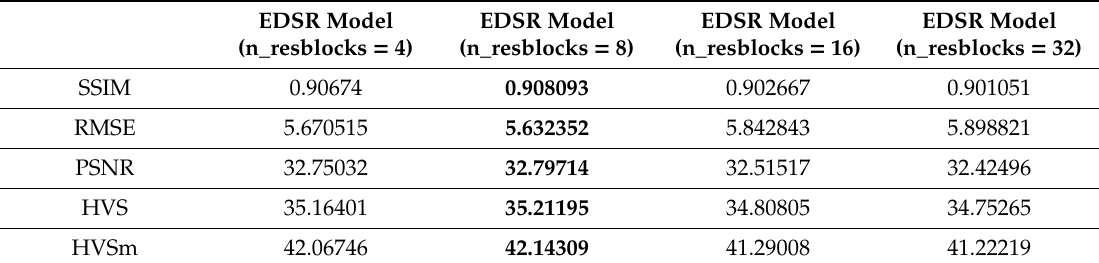
Table 7. Average of image quality measures for 20 enhanced “down-sampled ( × 2) left” camera images with four EDSR models. Bold format indicates the method providing better